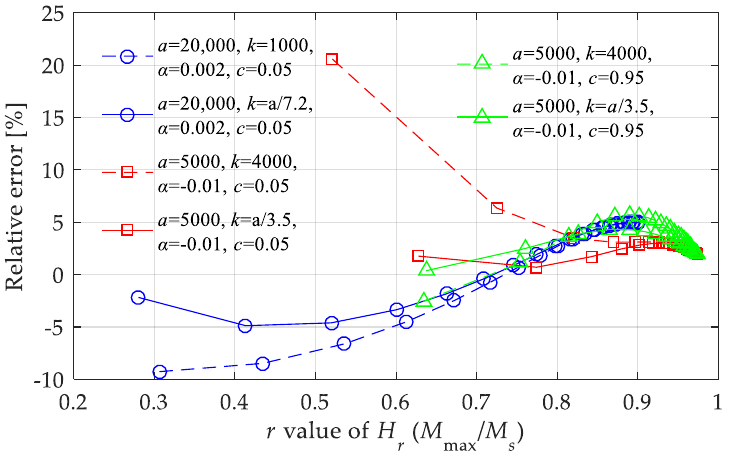
Figure 16. Relative errors of the nonlinear model under boundary conditions with highest errors.